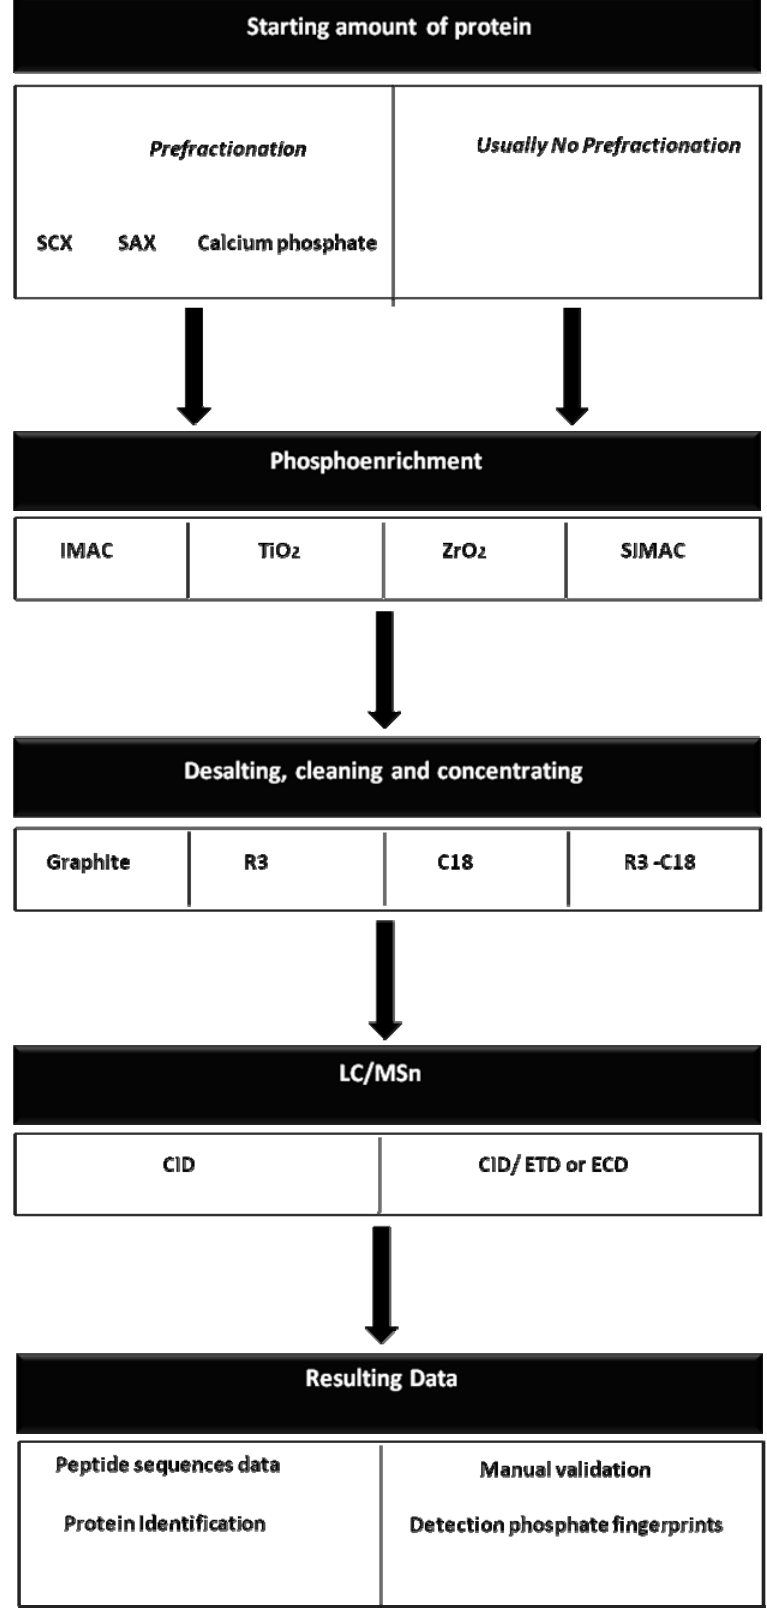
Figure 2. The workflow of current strategies for large-scale phosphoproteomics analyses. Different strategy-combinations can be coupled in order to recover and identify the maximum number of